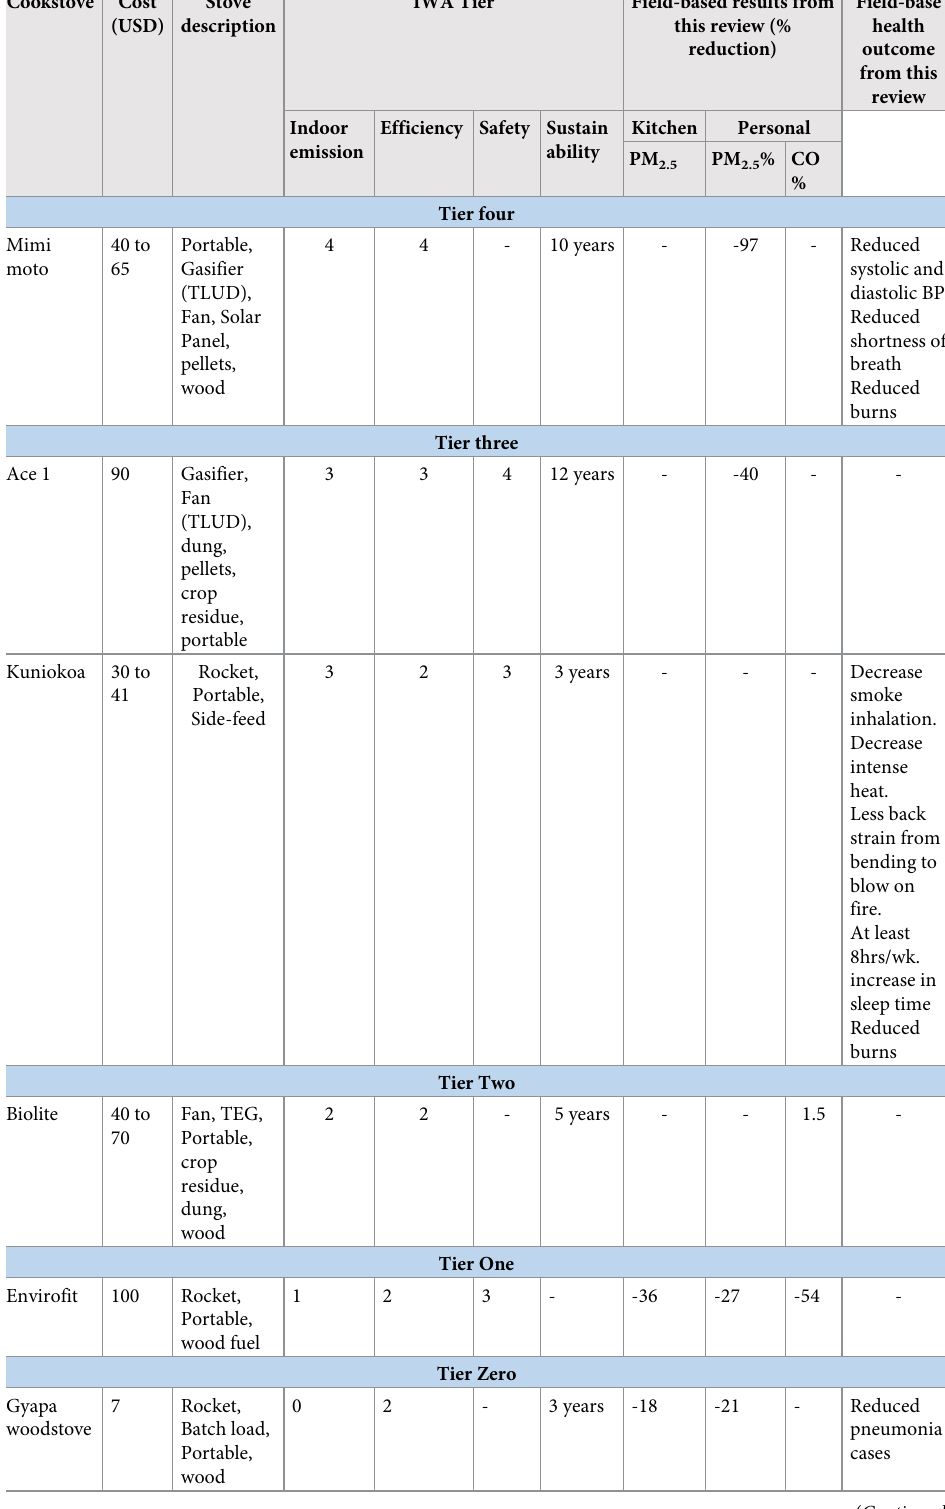
Table 6. Available cookstoves by IWA tier and field emissions score